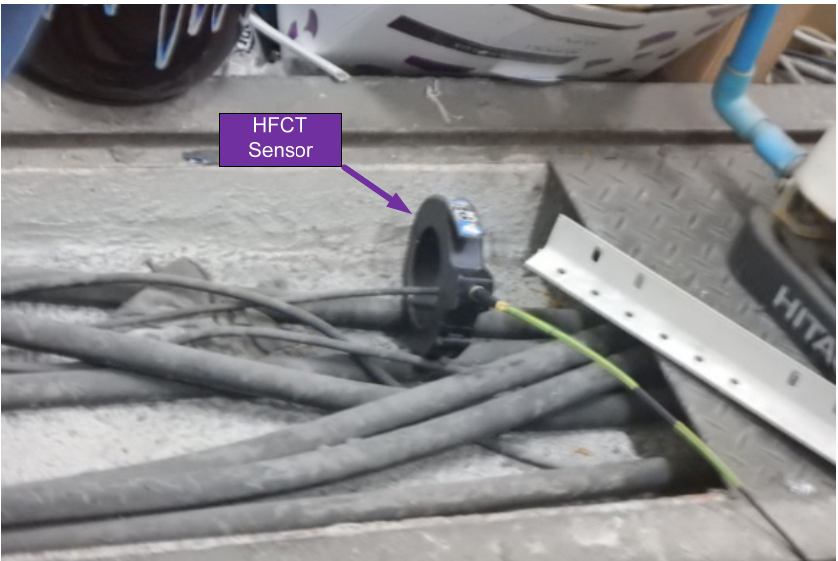
Figure 7. installation of HFCT at ground wire of transformer. Figure 7. Installation of HFCT at ground wire of transformer.